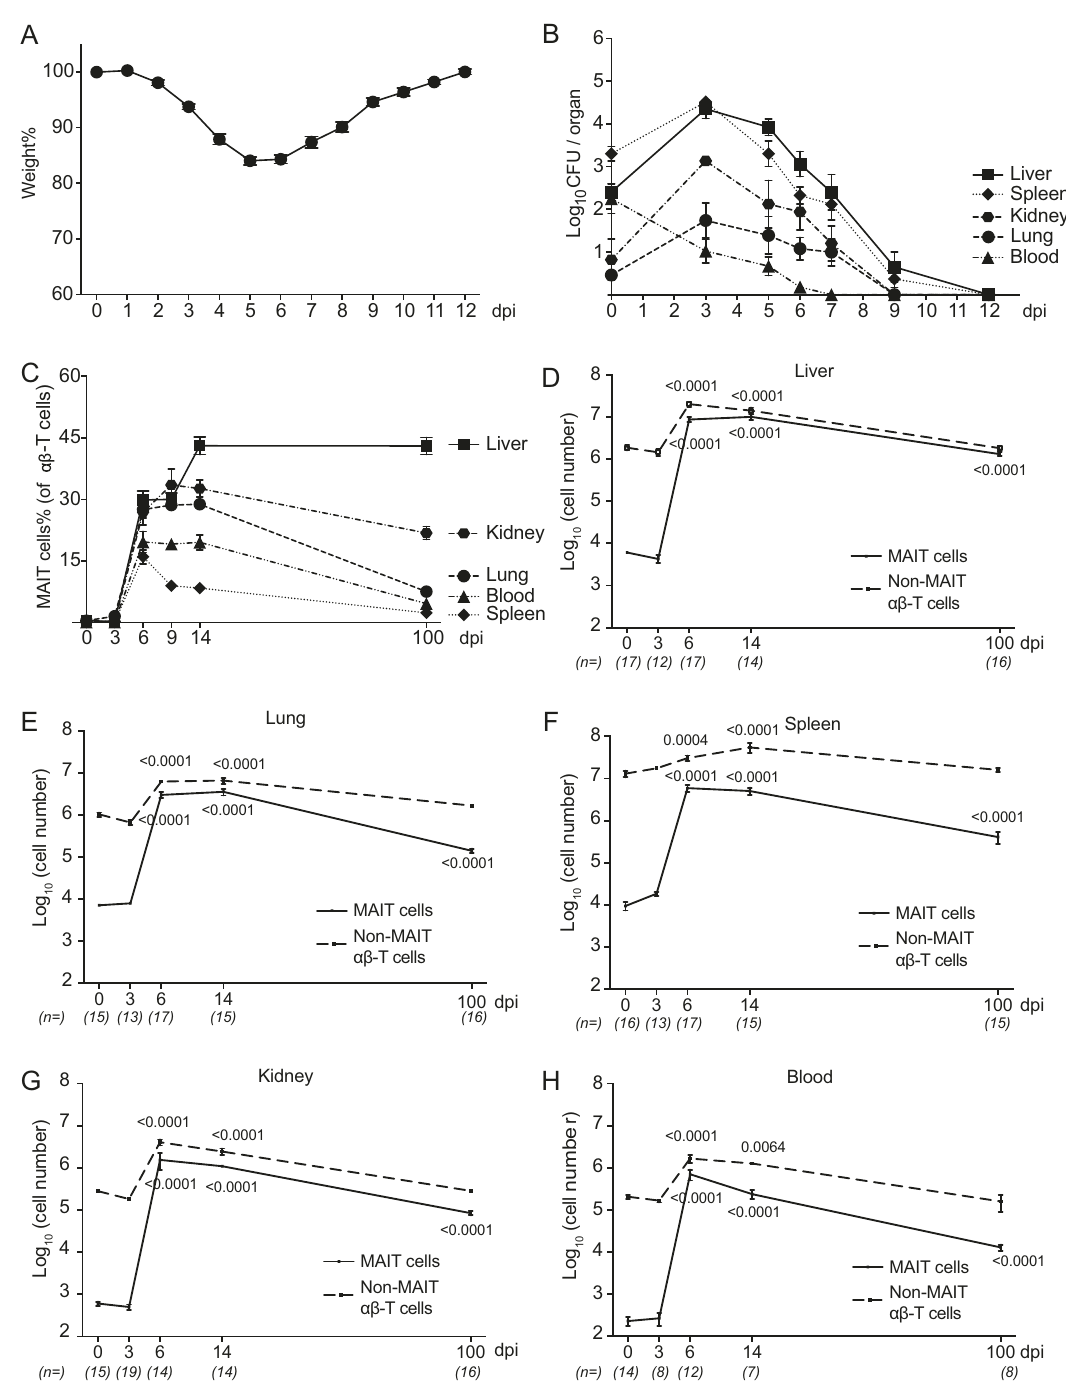
Fig. 2 Systemic and long-lasting expansion of MAIT cells in F. tularensis LVS infection. A Body weight was recorded daily and calculated in percentage relative to starting weight of the individual mouse. Data are presented as mean ± SEM ( n = 20 mice). B Bacterial load (CFU/organ or CFU/100 μ l blood) from C57BL/6 mice at indicated time points post infection i.v. with 2 × 10 4 CFU F. tularensis LVS. Data are presented as mean ± SEM. n = for day 0, 3, 5, 6, 7, 8, and 12: liver 4, 14, 8, 14, 8, 10, 6; spleen 4, 14, 8, 18, 6, 16, 6; kidney 4, 6, 8, 11, 11, 6, 6; lung 5, 14, 8, 20, 9, 16, 6; blood 4, 13, 8, 14, 8, 7, 6 individual mice. C – H Relative and absolute number of MAIT cells and non-MAIT αβ -T cells detected in various organs (as indicated) from naive and infected mice at indicated time points post infection. Pooled data from three independent experiments (mean ± SEM, n = 7 – 17 mice per group, as indicated). Statistical test: one-way ANOVA comparing each time point with 0 dpi, p -values are indicated. Source data are provided as a Source Data fi